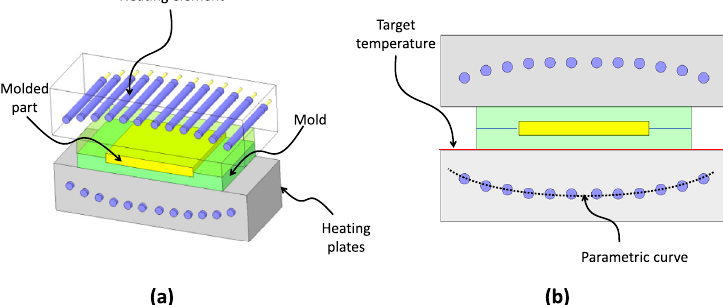
Fig. 1. Schematic representation of the heating plate containing heating sources and the mold with the polymer part inside.